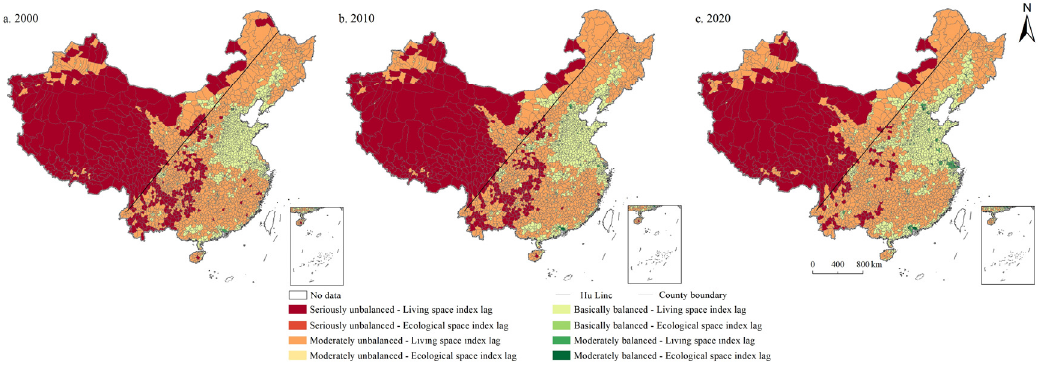
Figure 12. Spatial distribution of subcategories of coordination degree of LSI and ESI in China dur-